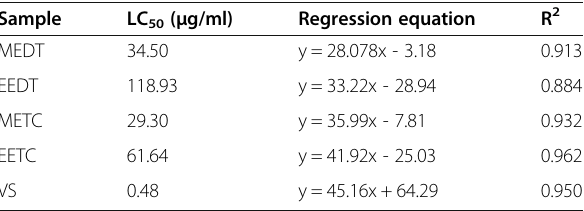
Table 6 Values of LC 50 and regression equations for different test extracts